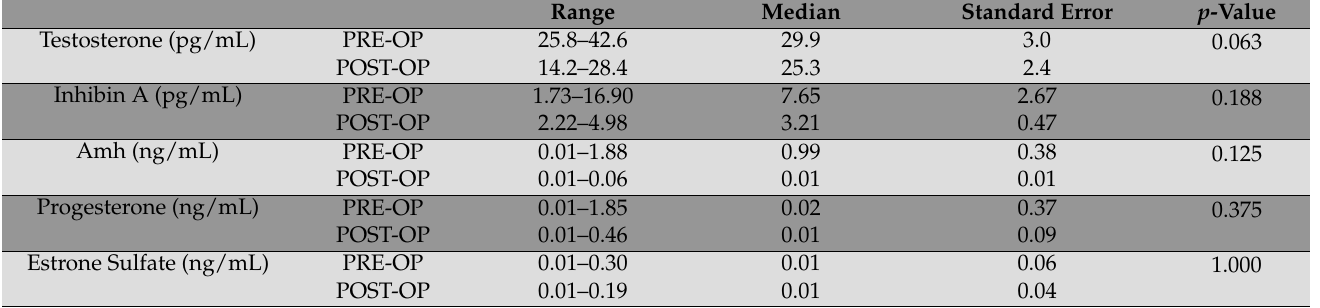
Table 2. Pre- and post-operative endocrine results and statistical